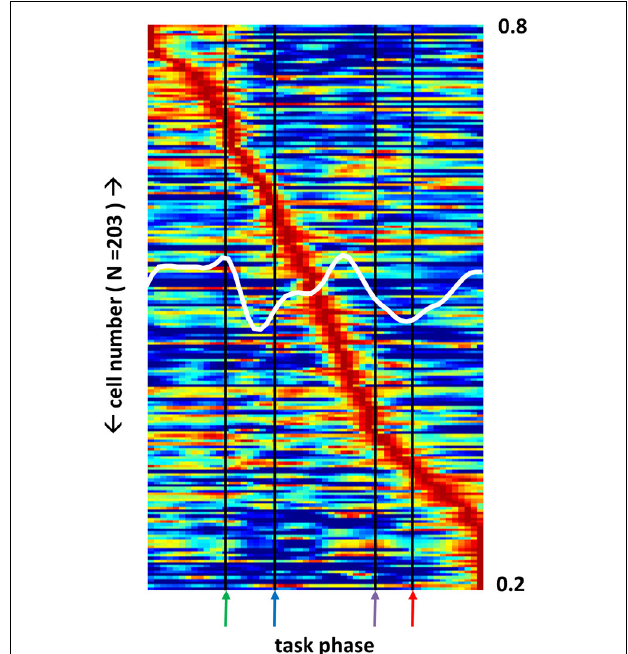
FIGURE 6 | Posterior parietal cortex neuron sub-populations exhibit firing peaks at all phases of a selective attention task. Firing rate across all task phases (x-axis) for 203 posterior parietal cortex (PPC) neurons (left y-axis). Each neuron’s firing rate is color-mapped as a proportion of its maximum firing rate observed during task performance (blue-red = 0–1). White trace (right y-axis) depicts the mean max-normalized firing rate among all neurons. As for basal forebrain (BF), different PPC neuron populations are maximally active at each task phase, but many fewer neurons exhibit responses to the light